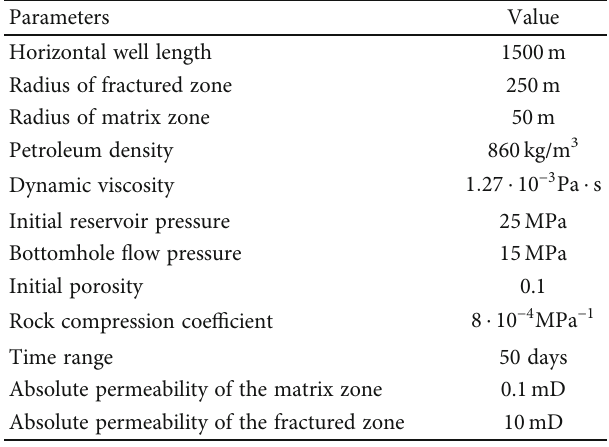
Figure 4: Numerical model of the fl ow fi eld around a fractured horizontal well in tight oil. Table 1: Speci fi c parameters of the numerical model.